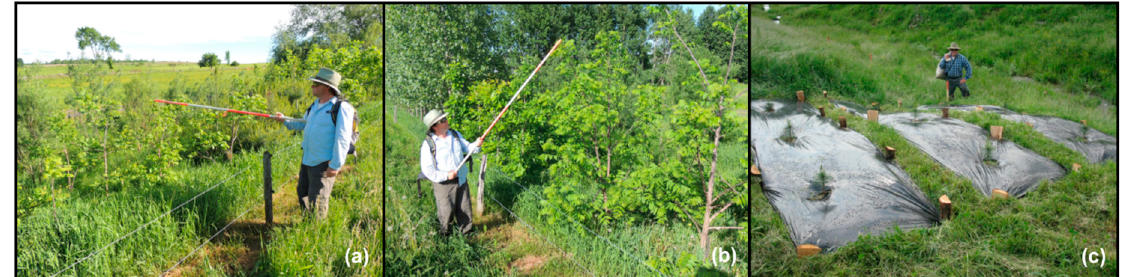
Figure 7. During the fifth growing season (June 2014), a dense herbaceous vegetation cover is observed underneath black walnut in the control treatment ( a ) and in the herbicide treatment ( b ). Permanent black plastic mulch treatment ( c ) restricts herbaceous vegetation growth over the long-term (photo taken after mulch installation around white pines in May 2010).